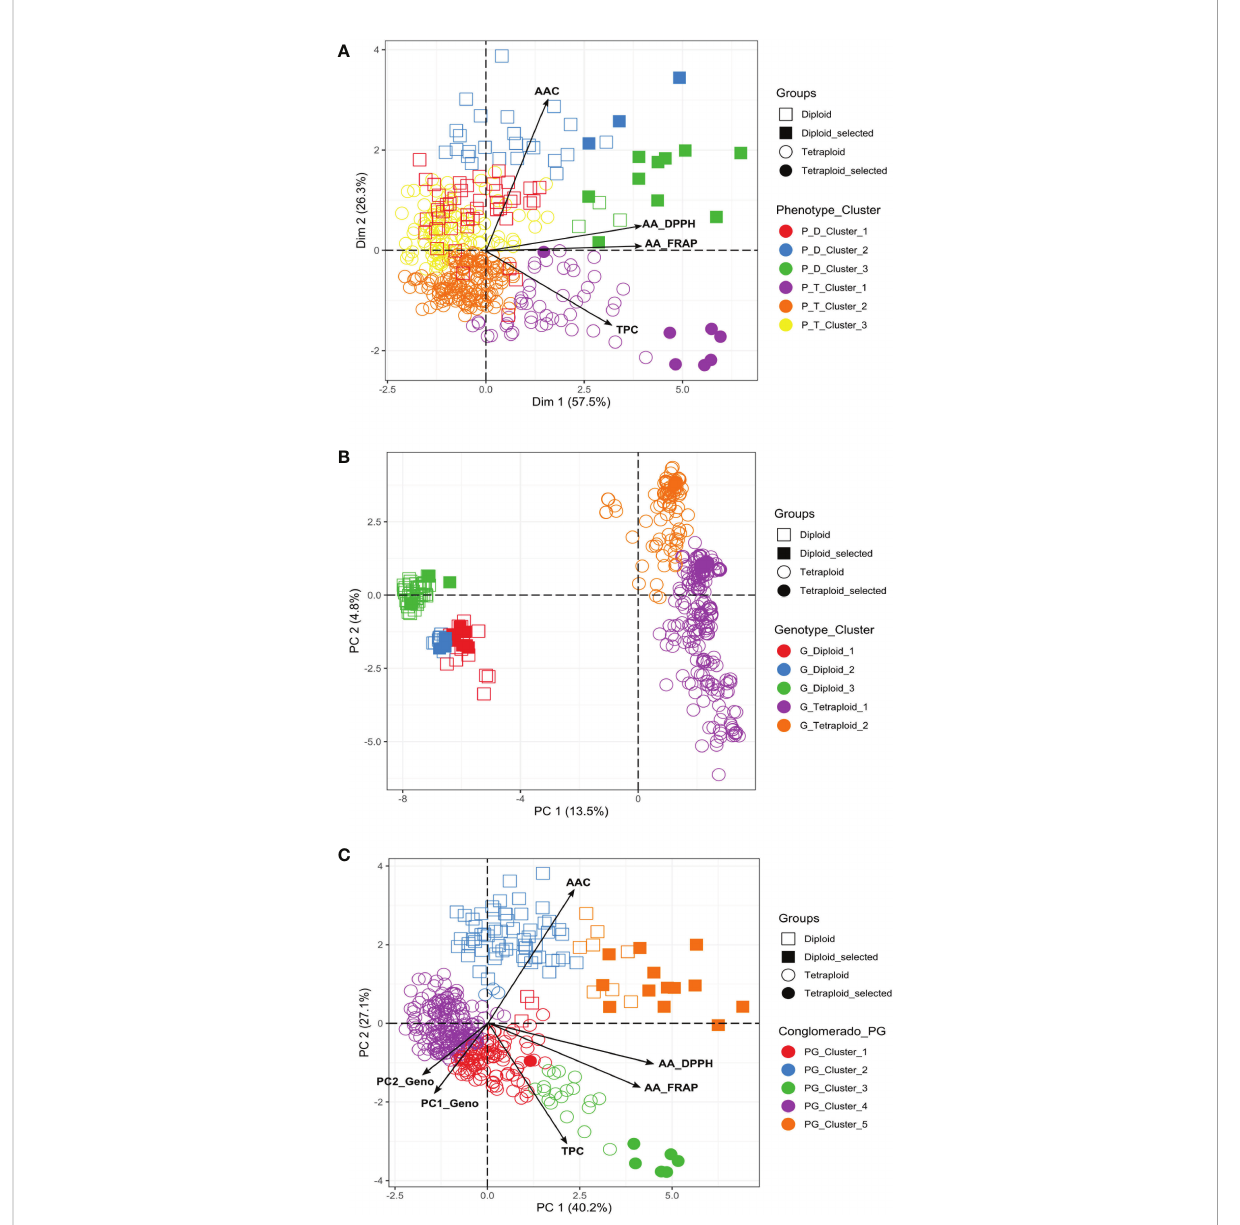
FIGURE 3 Principal Component Analysis (PCA) based on TPC, AA, and AAC phenotypic data and polymorphic molecular markers (4488 SNPs) for diploid and tetraploid accessions. (A) Phenotypic PCA (B) Genotypic PCA, and (C) PCA based on phenotypic and genotypic data. P, Population; D, Diploid; T, Tetraploid; G, Genotypic; PG, Phenotypic/Genotypic. The promising selected genotypes identi fi ed in this study were indicated in the fi gures. Additionally, the clusters showed in the fi gures were obtained from the phenotype, genotype, and phenotype/genotype multivariate